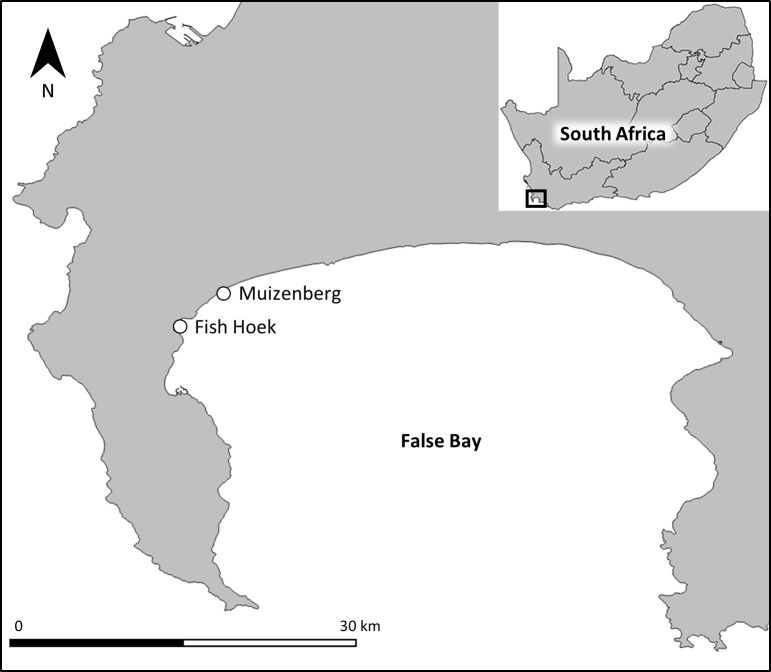
Locations of Muizenberg and Fish Hoek beaches in False Bay, South Africa.